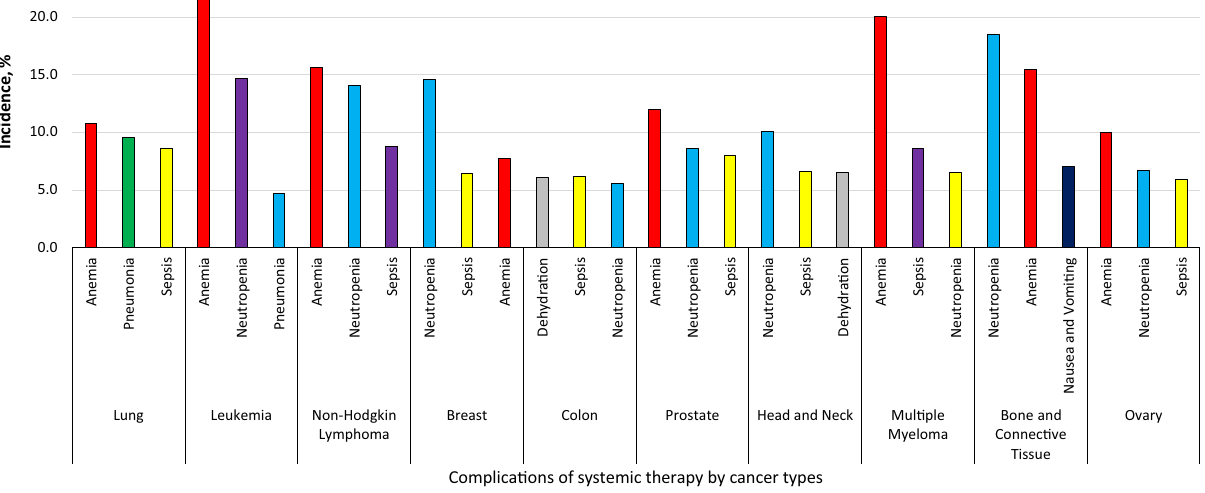
Figure 2. The most common complications of systemic therapy by the top 10 most common cancer